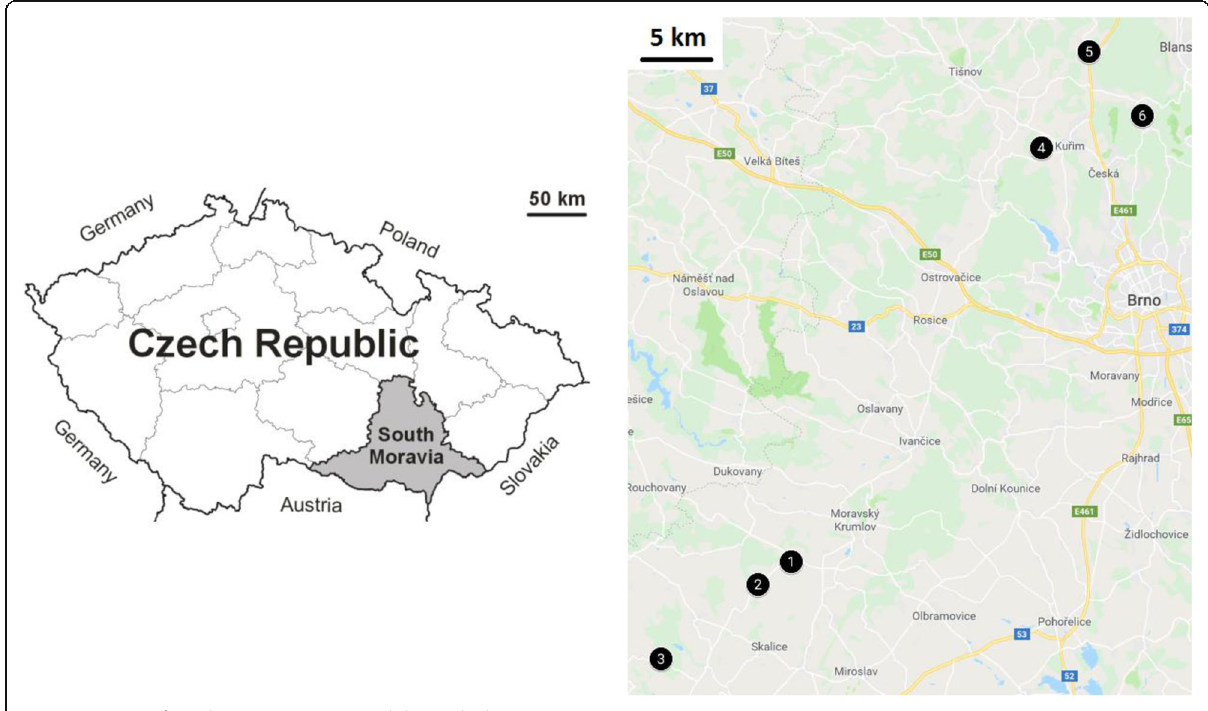
Fig. 3 Location of South Moravian region and the studied sites